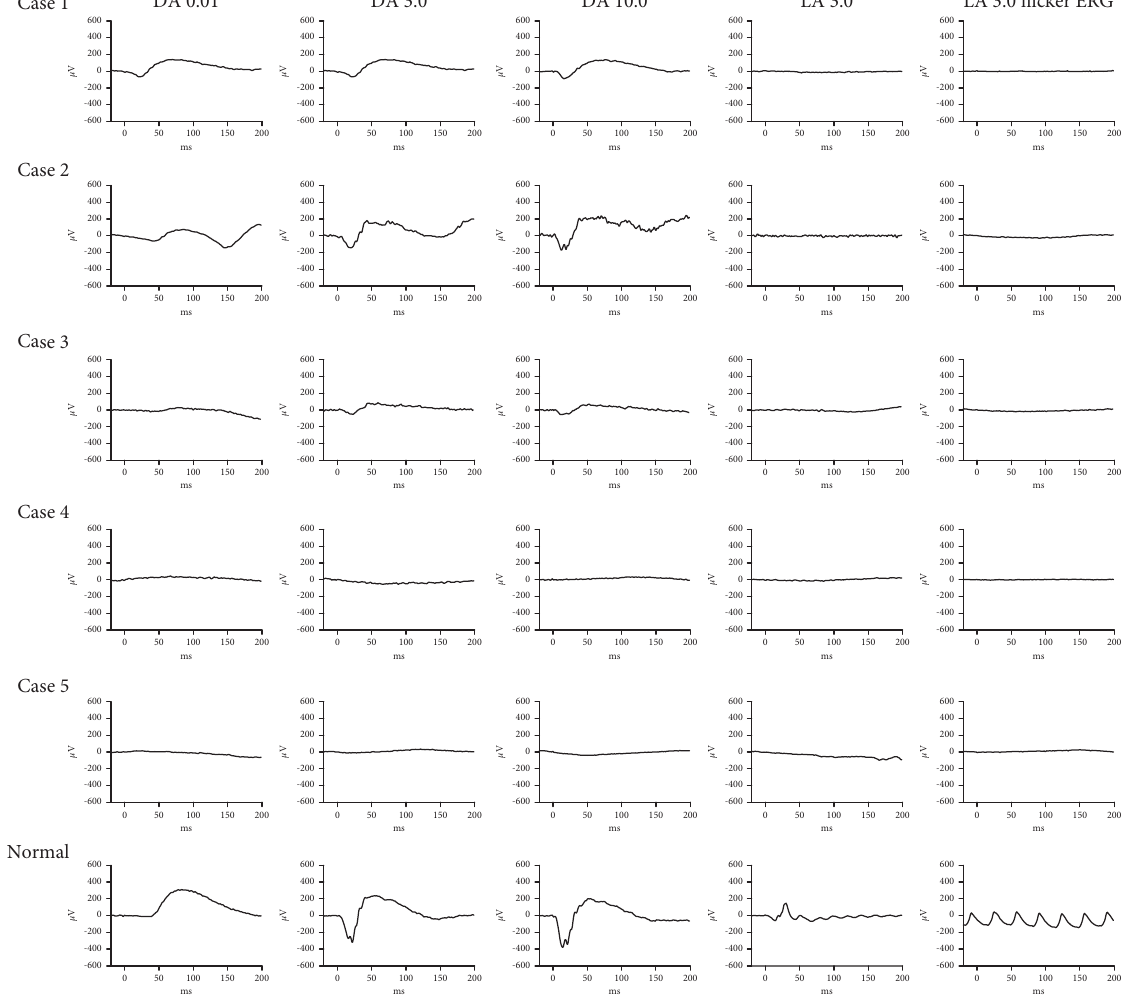
Figure 3: Full-field ERG recordings in patients with LCA6. Case 1, case 2, and case 3 all showed a moderate to severe loss of the rod-system response and an extinguished cone response, but case 3 had a worsened rod response compared to the other two. The rod responses and cone responses were nondetectable for case 4 and case 5. The last row is the normal